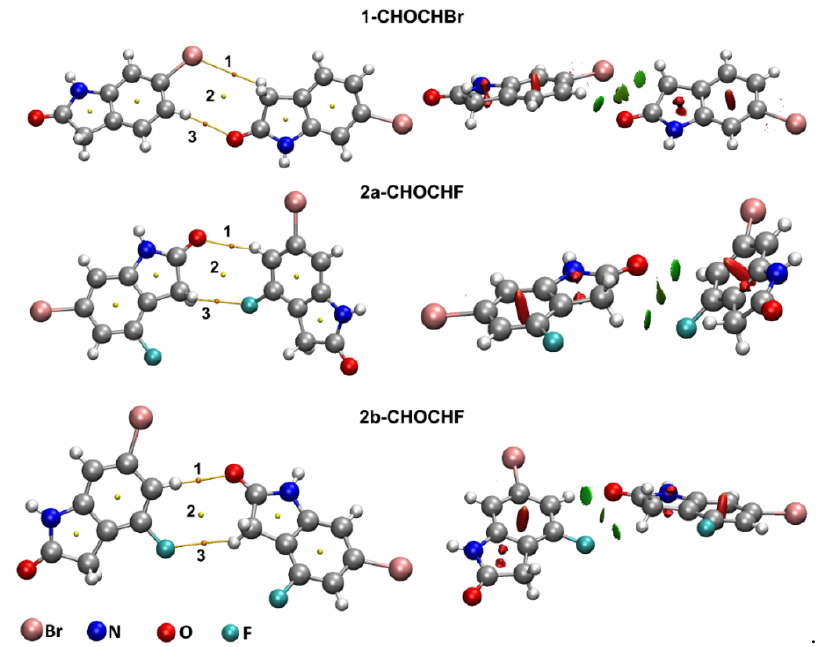
Figure 5. Critical points and RDG isosurfaces for 1-CHOCHBr, 2a-CHOCHF and 2b-CHOCHF dimers obtained with MP2/def2-TZVP theory level. The orange points indicate bond critical points (BCP), yellow points indicate ring critical points (RCP) and yellow lines indicate the bond paths. The RDG isosurfaces where obtained with isovalues of 0.65 a.u. The green-colored region indicates a